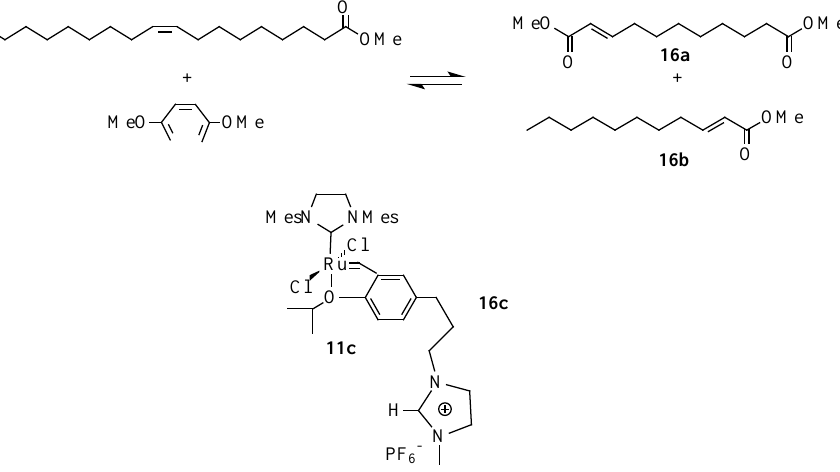
Scheme 9. Cross-metathesis of methyl oleate with dimethyl maleate using 16c